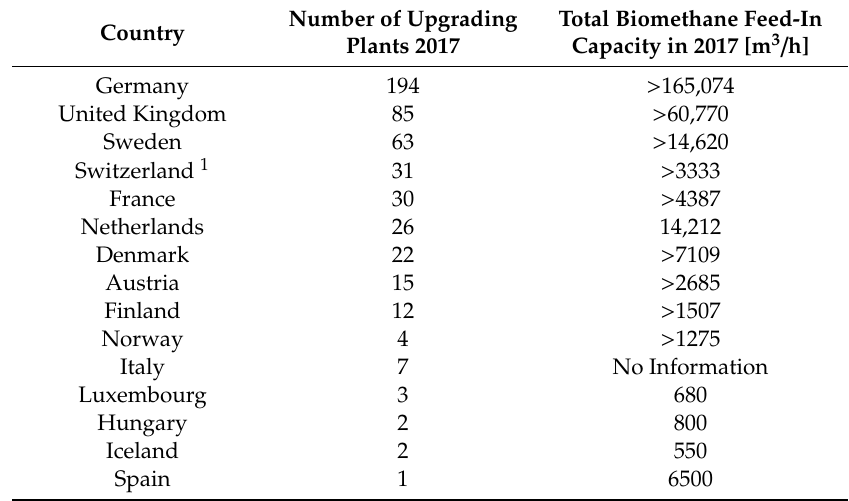
Table 1. Total number of operational biomethane plants and biomethane feed-in capacity in the EU-28 and European Economic Area (EEA) members in 2017 [58].